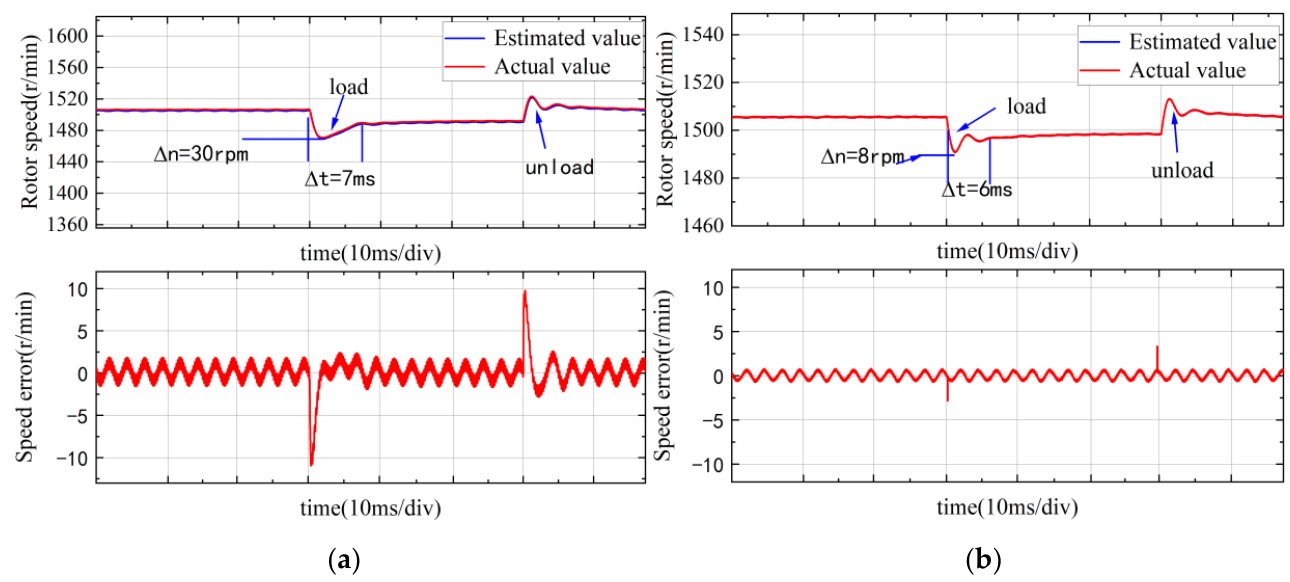
Figure 21. Rotor speed loading experimental results: ( a ) traditional SMO; ( b ) improved SMO.